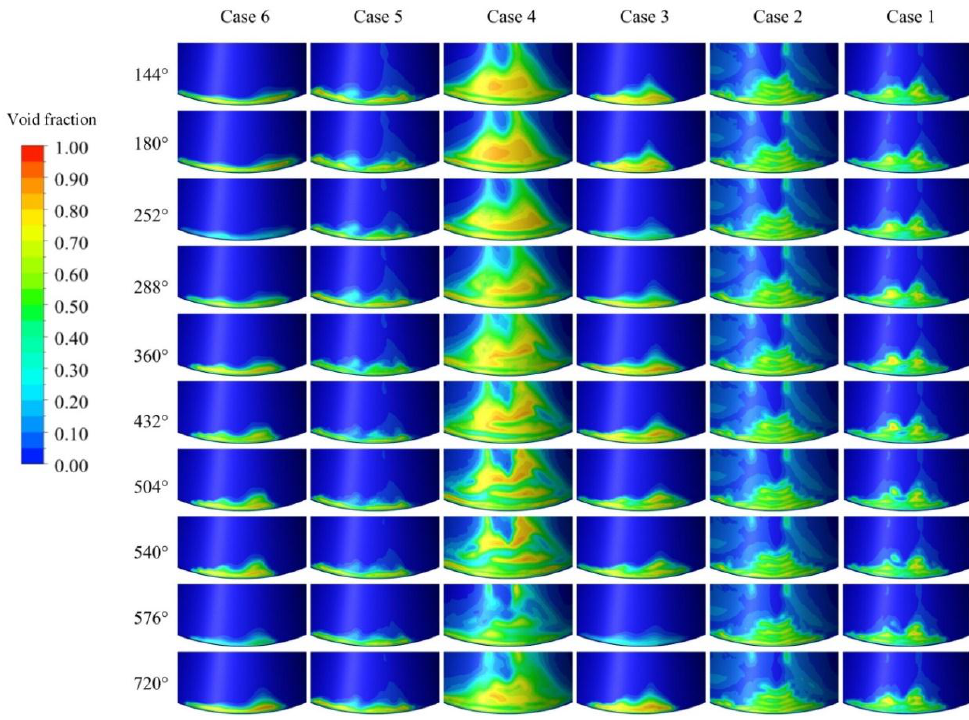
Figure 12. Gas phase distribution of crank angles.